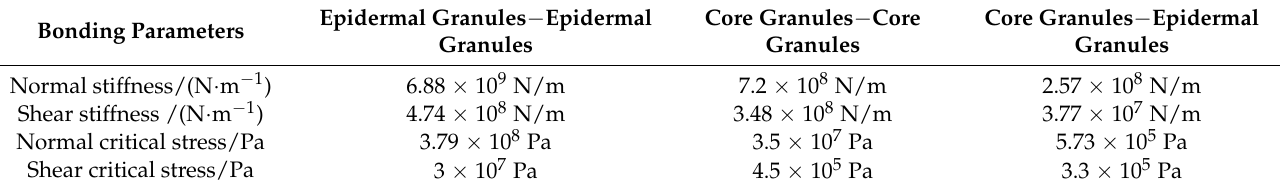
Table 12. Whole straw bonding parameters.